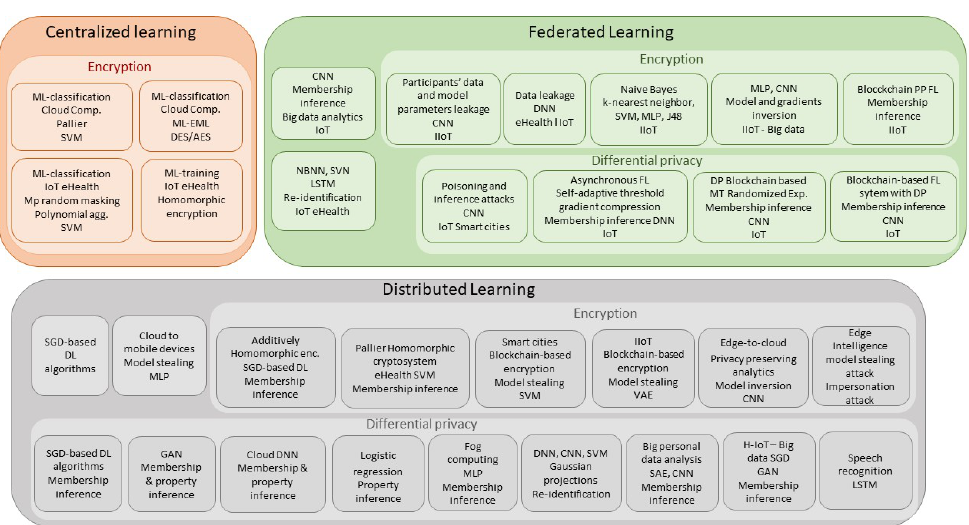
Figure 3. Overview of ML privacy based solutions in